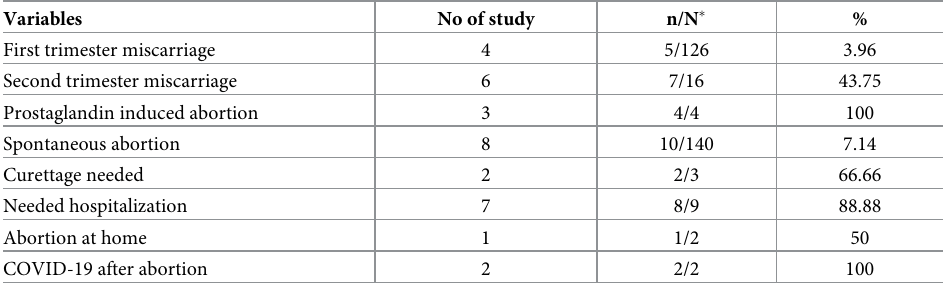
� n: number of patients with any variable, N: Total number of mothers with COVID-19.